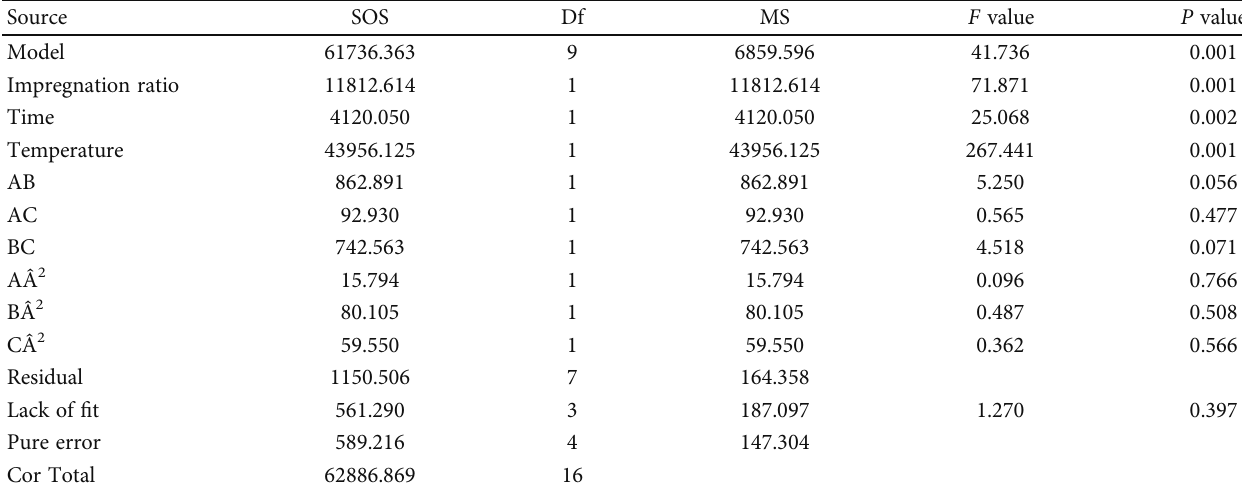
Table 3: ANOVA prediction of methylene